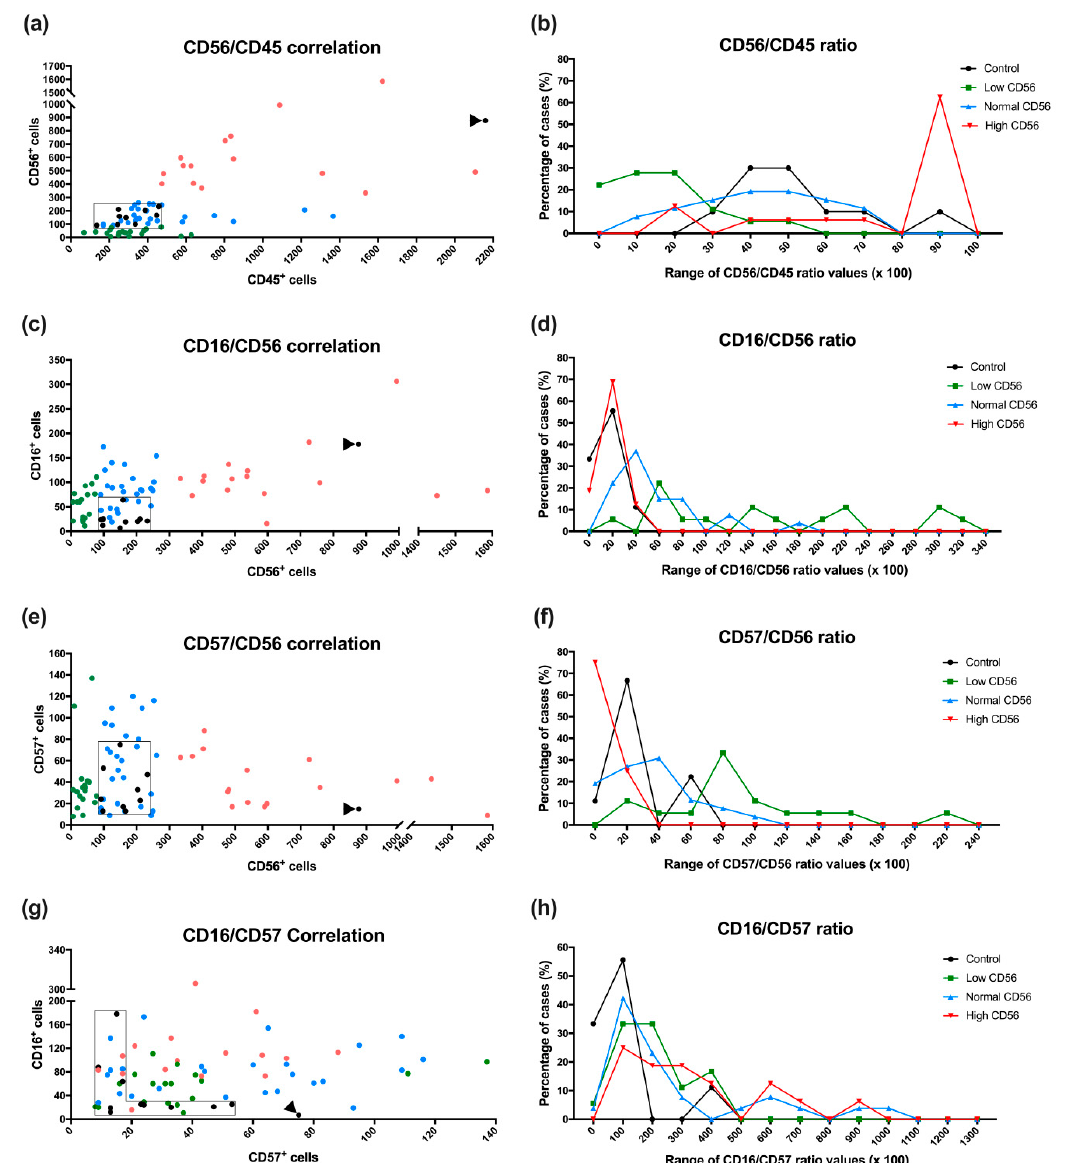
Figure 6. Correlation and ratio between CD56 / CD45 ( a , b ), CD16 / CD56 ( c , d ), CD57 / CD56 ( e , f ), and CD57 / CD16 ( g , h ) and distribution of their ratios (%) in the control ( n = 10) and uRPL groups ( n = 61): ( a , c , e , g ) each sample is represented by a dot (black: controls; green: uRPL-CD56 / low; blue: uRPL-CD56 / normal; and red: uRPL-CD56 / high). Boxes surround the control values, and arrowheads show a single outlier control sample with signs of inflammation. ( b , d , f , h ) Samples are classified in stepwise ranges based on their ratios as indicated in the x axes.